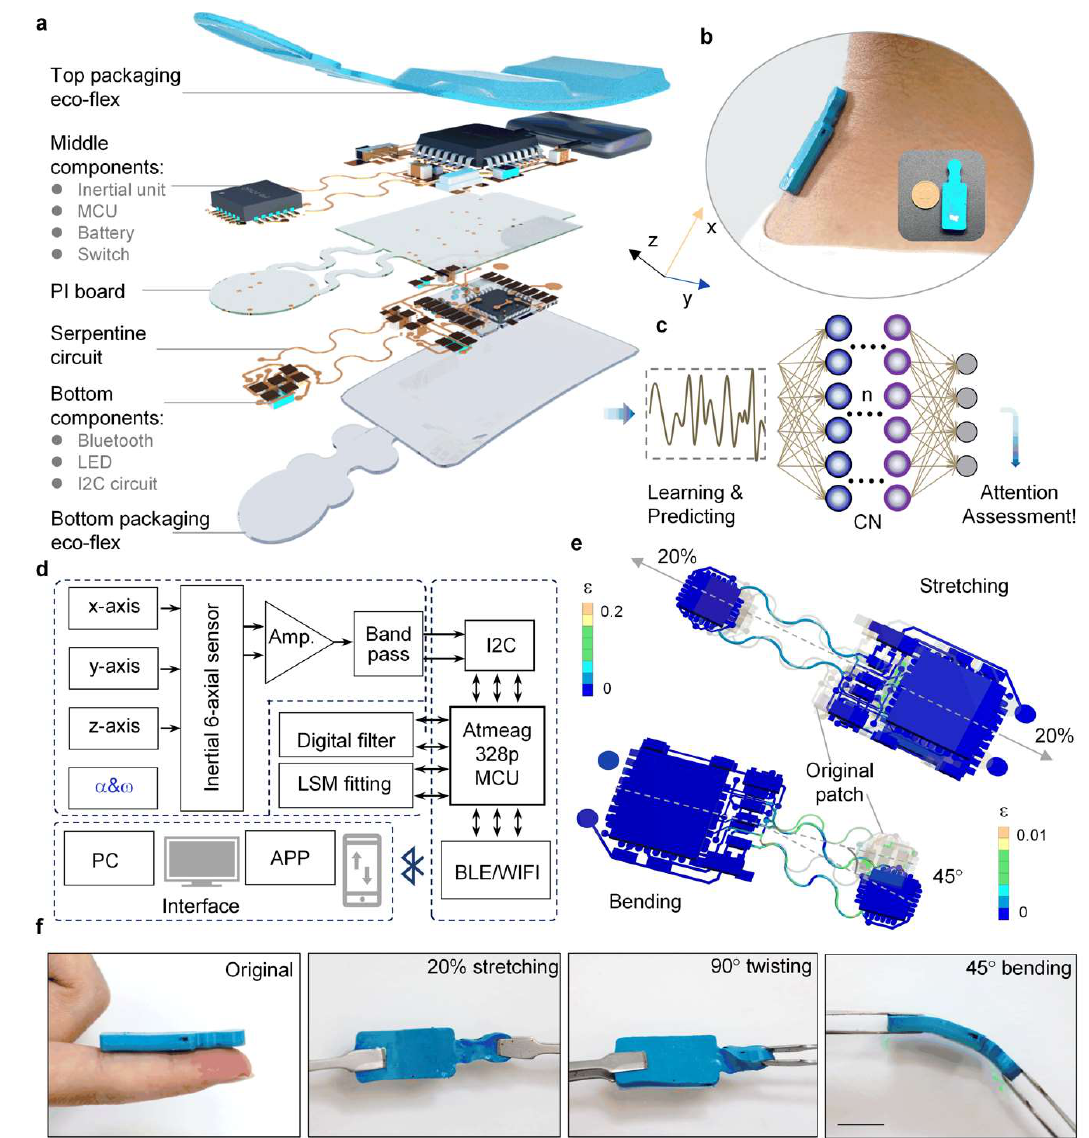
Figure 1. Design and mechanical deforming ability of the AID. ( a ) Mechanical structural and electrical schematic diagram of the AID. ( b ) Optical image of AID attached to the neck’s epidermis, and a corresponding frontal photo compared with a coin. ( c ) Attention assessment process via machine learning based on the monitoring of head postures. ( d ) Electrical block diagram of inertial signal processing and transmitting. ( e ) FEA’s strain diagram of the AID under 20% stretching and 45 ◦ bending deformations. ( f ) Images of the AID in elastic compliance in no load, torsion, twisting, and bending. Scale bar, 1